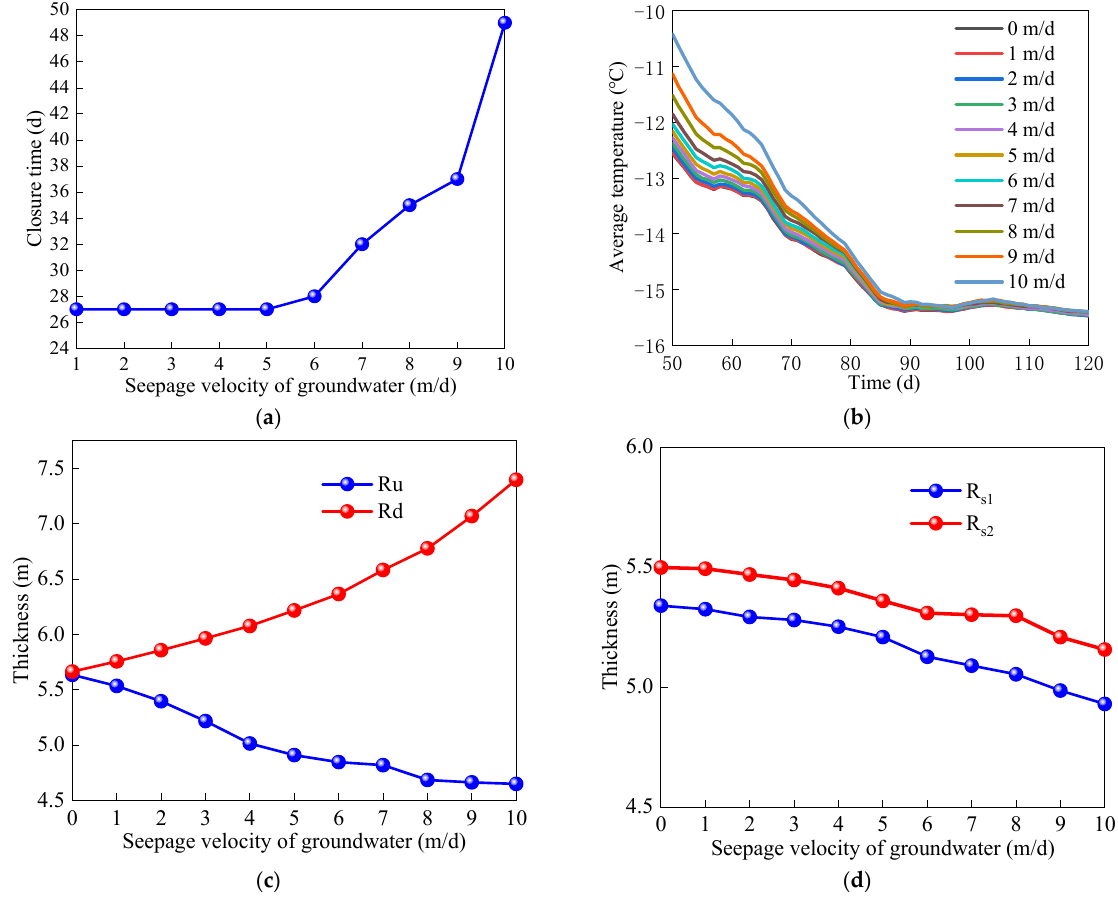
Figure 12. Impact of groundwater seepage on freezing temperature field. ( a ) Closure of frozen wall; ( b ) average temperature; ( c ) upstream and downstream thickness of frozen wall (frozen for 118 d); ( d ) flank thickness of frozen wall (frozen for 118 d).